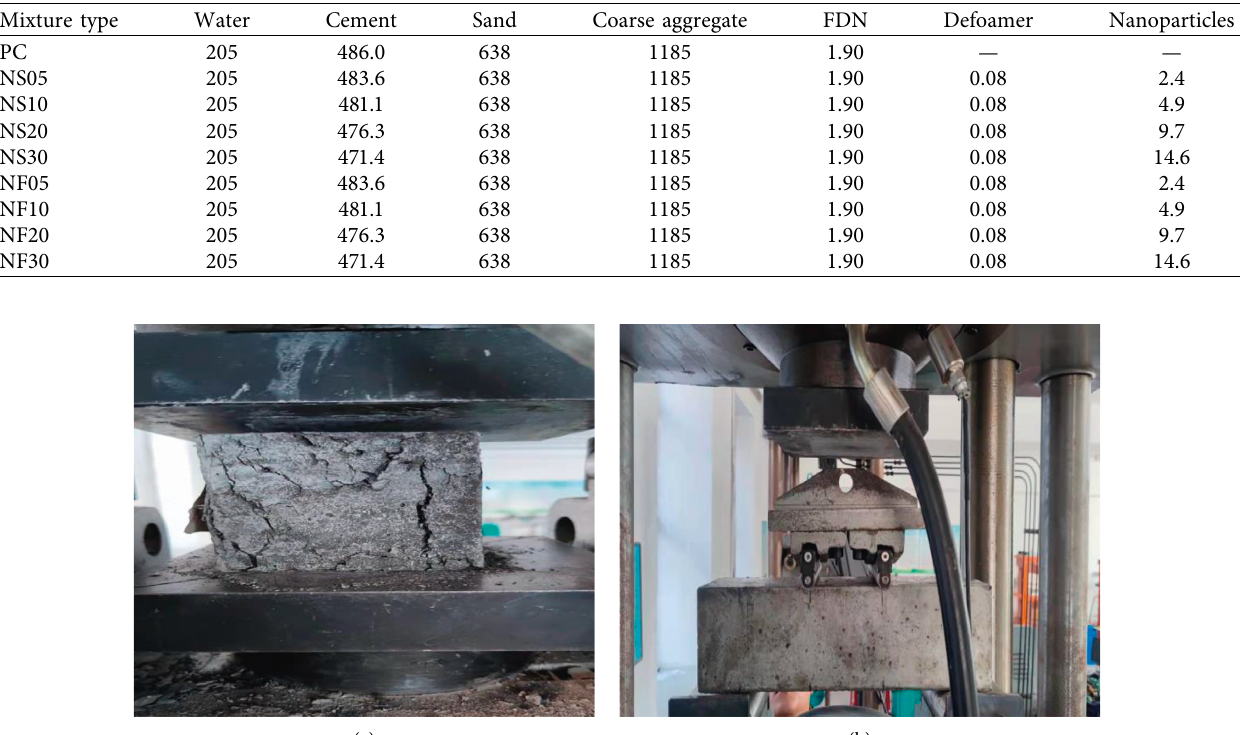
Table 2: Mix proportion of concretes (unit: kg/m 3 ).